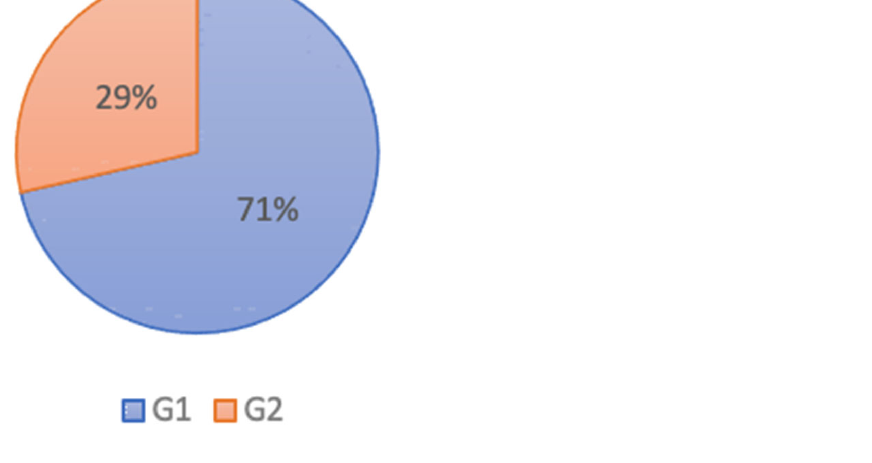
Figure 5. Distribution of participants by INS score; G1: score ≤ 5; G2: score < 5. People in the second group (Figure 6, left) tended to approach a “clean” scene and avoid a “polluted” landscape compared to the first group. The analyses showed no significant effect ( p = 0.59). An analysis of postural responses to “polluted” or “clean” environmental scenes according to each INS scale score is presented in Figure 6 on the right side. Subjects with a strong connection to nature (those with a score of 7) tend to avoid “polluted” landscapes compared to other subjects. This effect is not significant ( p = 0.44), as the number of subjects giving each score is limited.